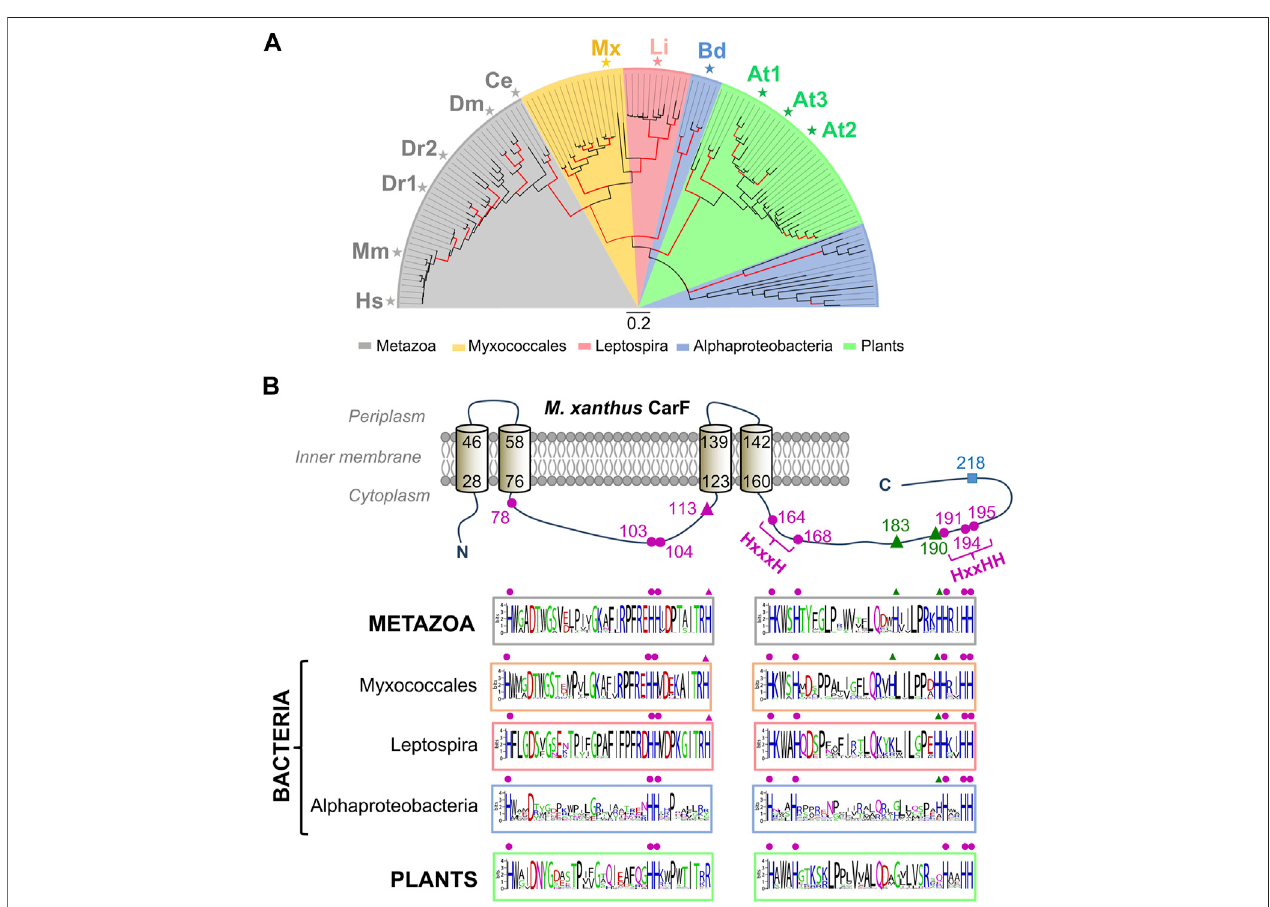
FIGURE 5 | Phylogenetic distribution and conserved histidines of CarF homologues. (A) Phylogenetic tree for CarF homologues in metazoa, bacteria and plants (maximum-likelihood with red branches for ≥ 75% con fi dence from 200 bootstrap replicates; scale bar, number of substitutions per residue; key below for colored sectors; adapted from (Padmanabhan et al., 2021). Homologues that were tested for CarF function in M. xanthus are indicated: Hs, Homo sapiens ; Mm, M. musculus ; Dr, D. rerio (two homologues); Dm, D. melanogaster ; Ce, C. elegans ; Mx, M. xanthus ; Li, Leptospira interrogans ; Bd, Bradyrhizobium diazoef fi ciens ; At, A. thaliana (three homologues). (B) Top: M. xanthus CarF cartoon representation with its experimentally established four transmembrane-helix topology (helix delimiting residues numbered) and twelve histidines (all cytoplasmic and numbered). CarF histidines conserved in all homologues, whose mutation abolishes function, are depicted by the magenta dots; the one histidine in CarF present in homologues from metazoa, myxobacteria and Leptospira and also essential for function is depicted by the magenta triangle; the two histidines conserved only in some homologues (primarily, from metazoa and myxobacteria), whose mutation has no effect, are depicted as green triangles;thenon-conservedandnon-essentialCarFhistidine(H218)isdepictedasacyansquare.Bottom:sequencelogosforsegmentscontainingtheconservedand semi-conserved histidines in CarF homologues from metazoa, bacteria and plants (histidines are aligned with the equivalent ones in the CarF cartoonand marked using the same symbols; adapted from (Gallego-García et al., 2019)).